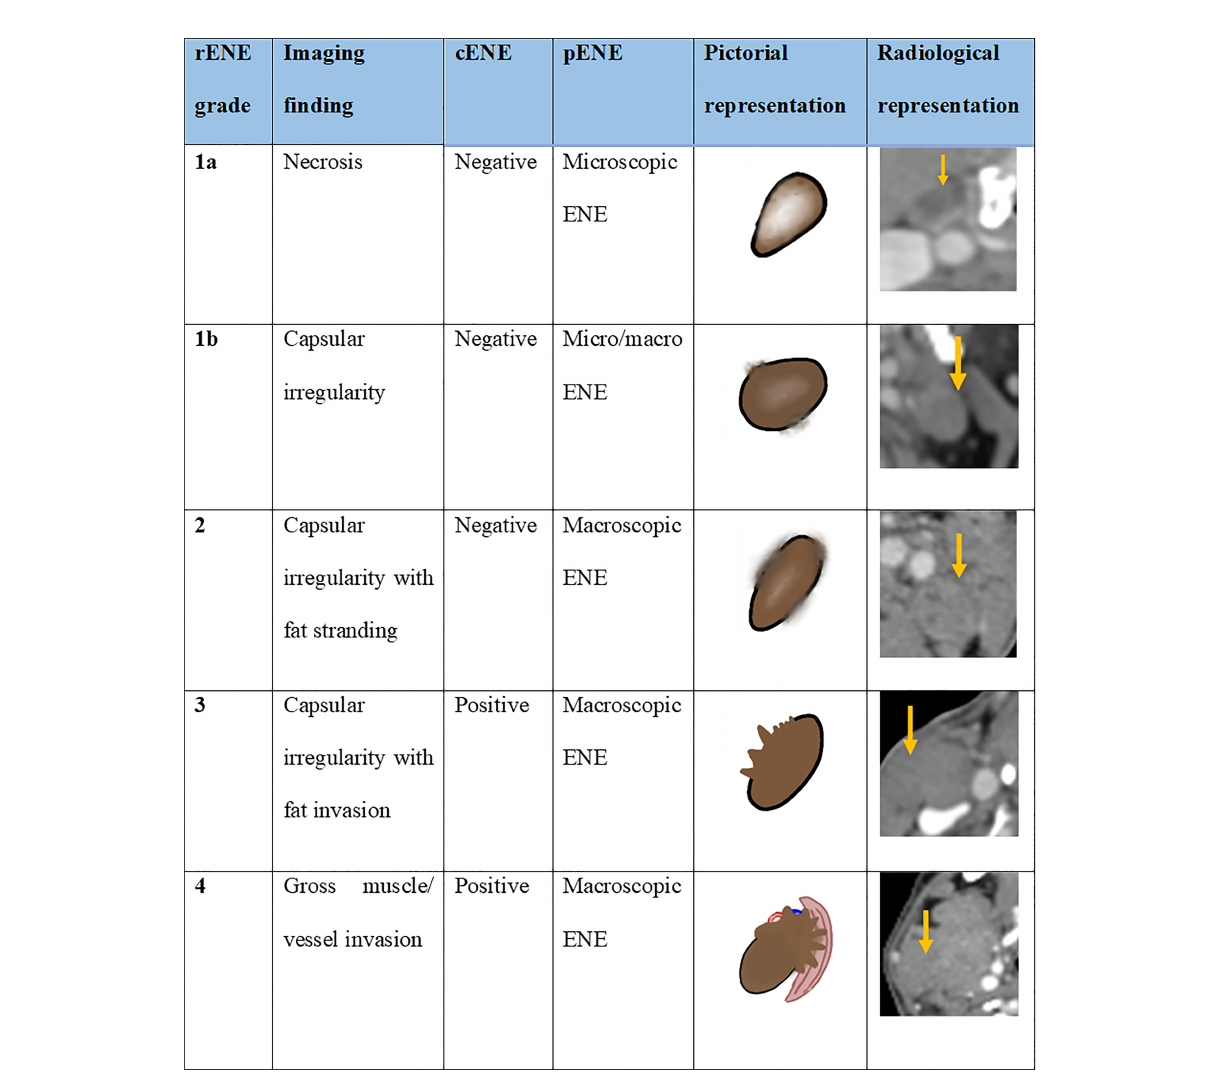
FIGURE 8 | The proposed imaging-based mahajan grading system for radiological extranodal extension (rENE) and their clinical ENE (cENE) and pathological ENE (pENE)